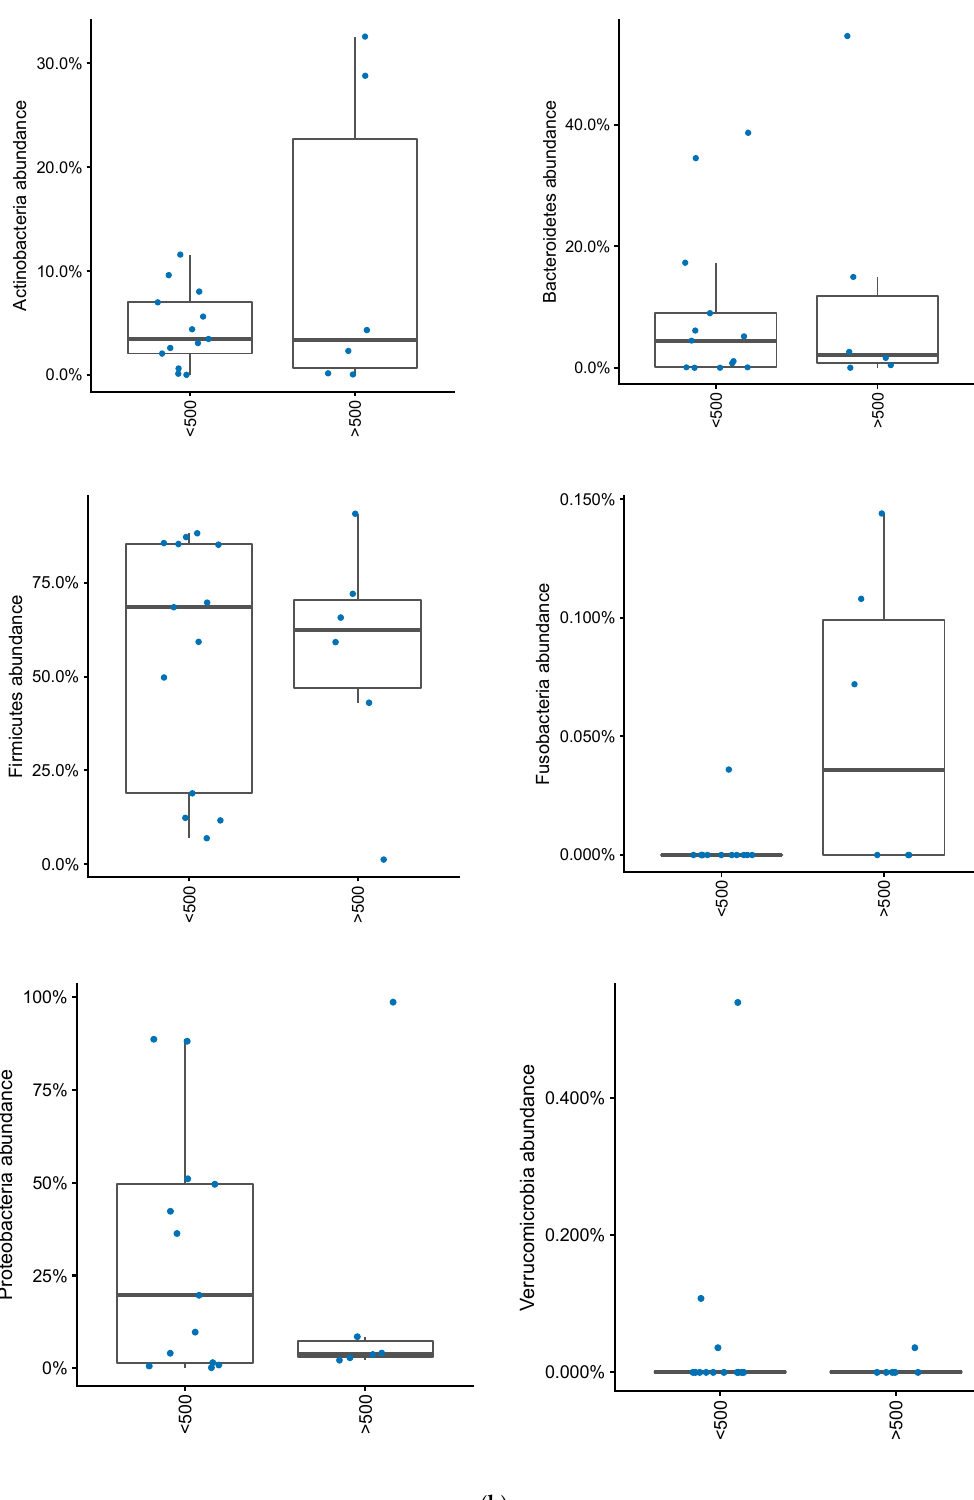
Figure 6. ( a ) Changes in bacterial phyla in patients with an ileo-anal pouch anastomosis, with or without active pouchitis. Pouchits defined as as a mPDAI score of 3 or above. ( b ) Changes in bacterial phyla abundances in patients with an ileo-anal pouch anastomosis, with or without increased inflammation in their pouch. Increased inflammation was defined as a fecal calprotectin greater than 500.